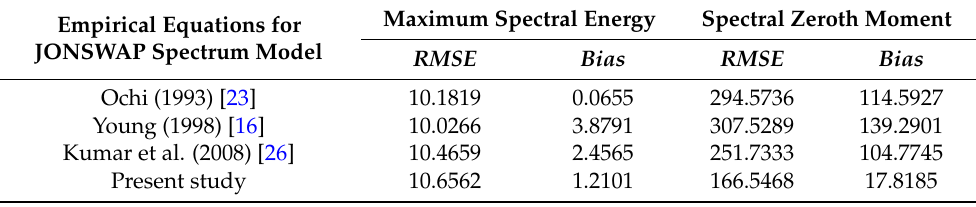
Table 11. The comparisons of wave energy estimation using different empirical equations under typhoon conditions.